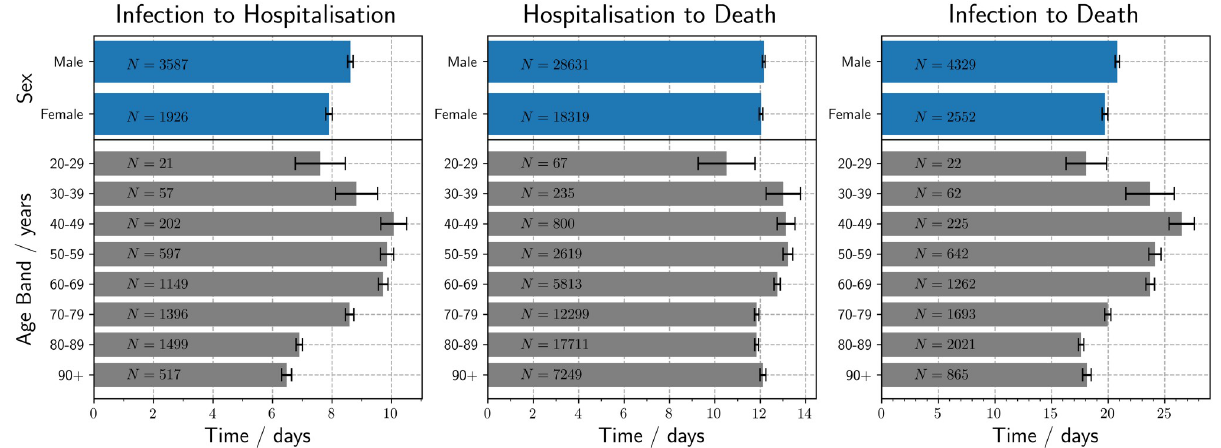
Fig 1. Bar charts of the times to clinical outcome by age and sex, with standard errors. The data were filtered for dates between January 2020 to November 2020 and N on each bar represents the number of patients within each group.